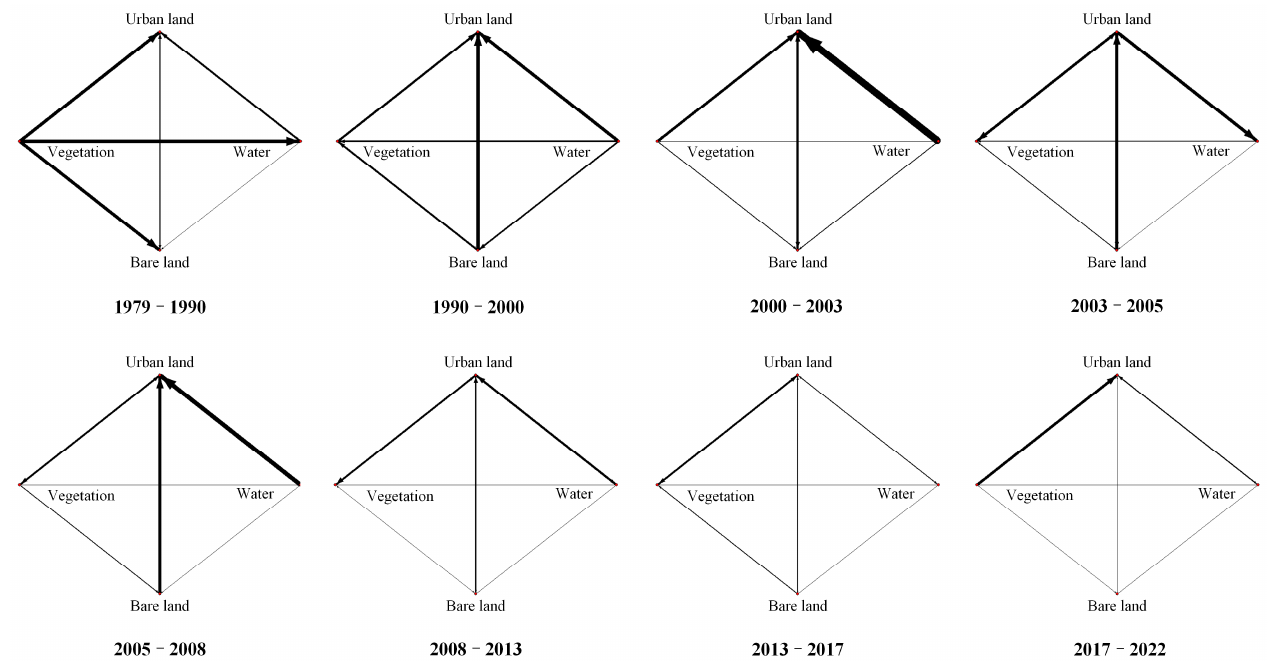
Figure 7. The complex network visualization of the land cover transformation in the 3 km buffer zone of the Shenzhen coastline from 1979 to 2022.